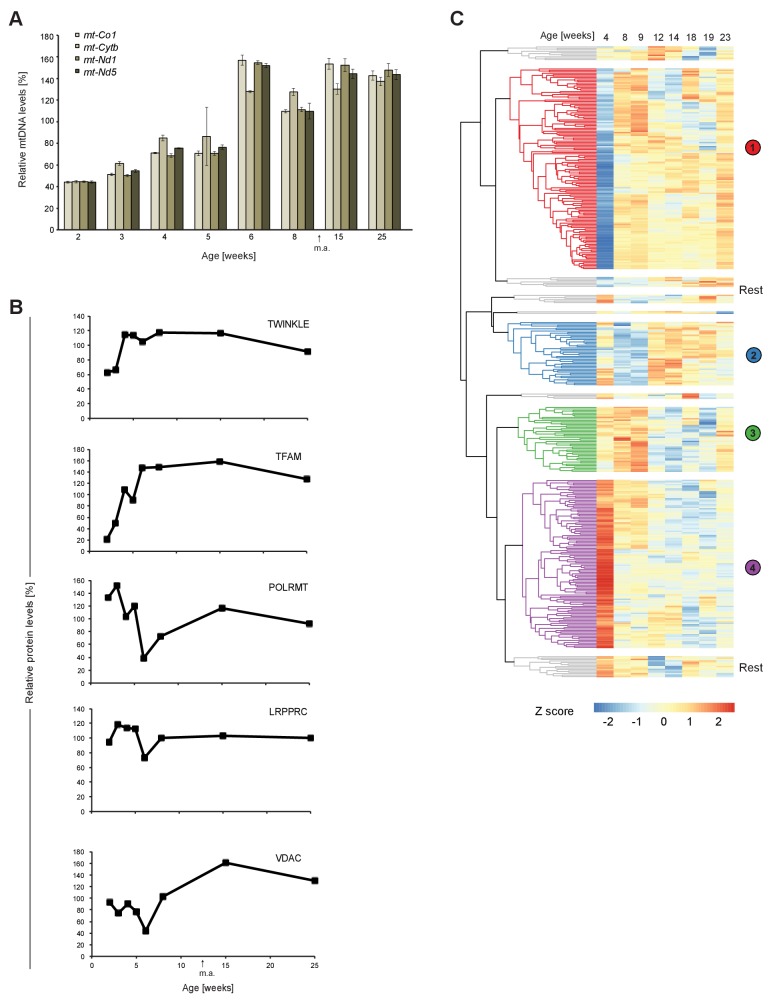
Rapid post-natal increase of mtDNA levels and factors required to maintain and express mtDNA in young wild-type mouse heart.(A) mtDNA levels in total DNA from wild-type (+/+) mouse heart at different ages. 18S rDNA was used to normalize nuclear input. (B) Immunoblot quantification of some mitochondrial protein levels in heart extracts from wild-type mice at different ages. α-Tubulin was used for normalization. (C) Clustering analysis of significantly changing mitochondrial proteins in control mice (L/L) at different ages. m.a. = mature adulthood.10.7554/eLife.30952.011Figure 2—figure supplement 1—source data 1.qPCR determination of mtDNA levels in wild type mice.10.7554/eLife.30952.012Figure 2—figure supplement 1—source data 2.Densitometry analyses of western blots on total proteins.